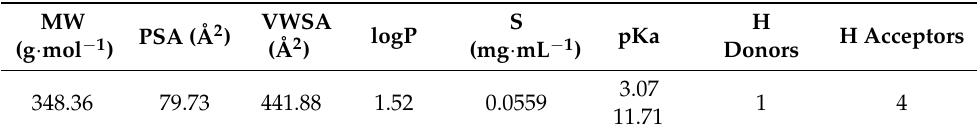
Table 1. In silico prediction of several physicochemical descriptors using the CPT chemical structure on Chemaxon ®